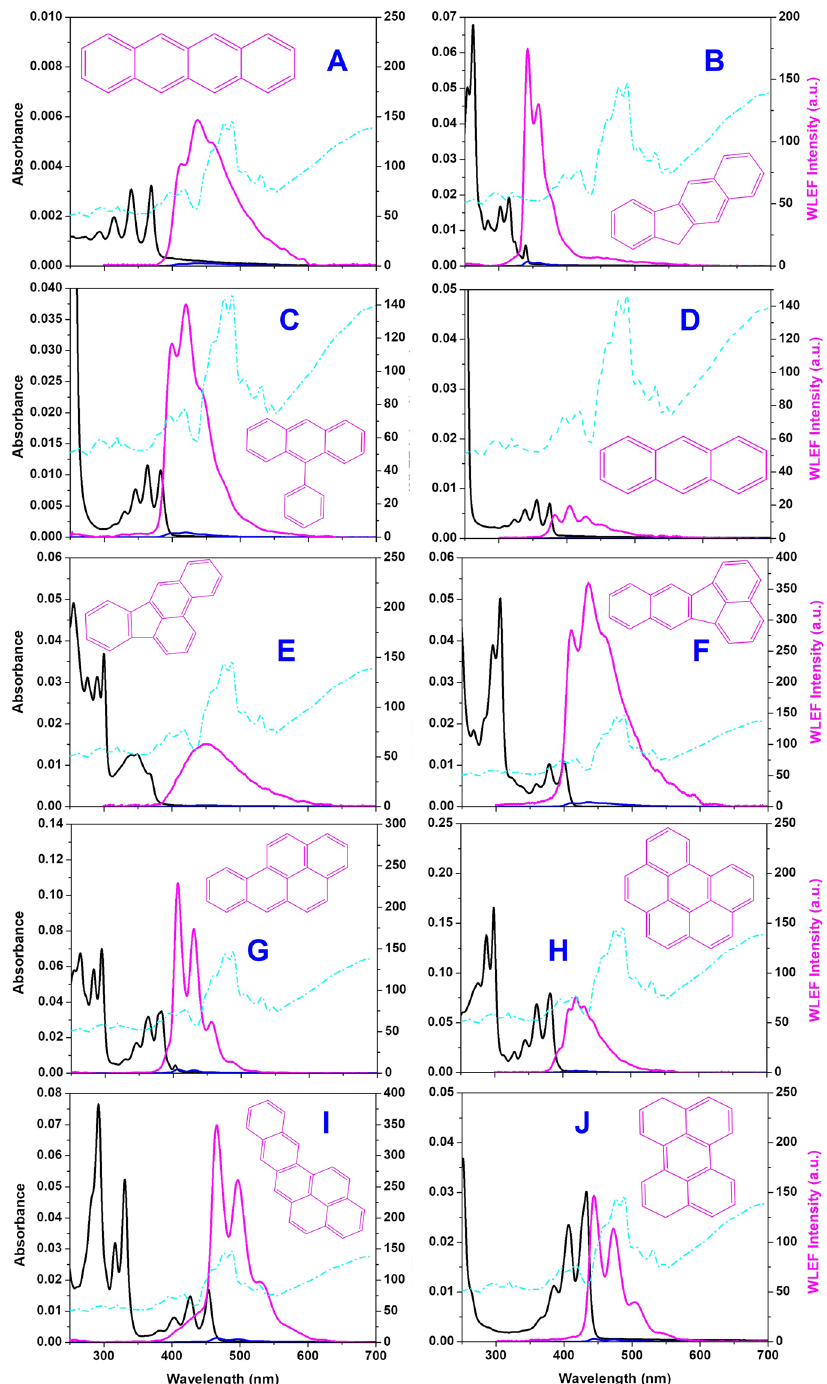
Figure 2. UV-VIS electronic absorption spectra (1 μ M, black) of PAHs, lamp profile (cyan) for electronic white excitation and WLEF spectra of PAHs (10 nM) in aqueous media in presence (magenta) and absence (blue) 5 mM CTAB surfactant media {[ A ] 2,3-Benzanthracene (BA), [ B ] 2,3-Benzofluorene (BF), [ C ] 9-Phenylanthracene (PA), [ D] Anthracene (Anth), [ E] Benz[e]acephenanthrylene (BeA), [ F ] Benz[k] fluoranthene (BkF), [ G ] Benzo[a]pyrene (BaP), [ H ] Benzo[ghi]perylene (BP), [ I ] Naphtho[2,3a-]pyrene (NP) and [ J ] Perylene